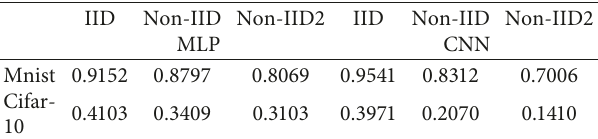
Figure 3: Model test accuracy on different distribution data. ( η � 0.001, frac � 0.1, (E) � 1, (B) � 10). Table 2: Model test accuracy on different distributed data (after 100 rounds training).